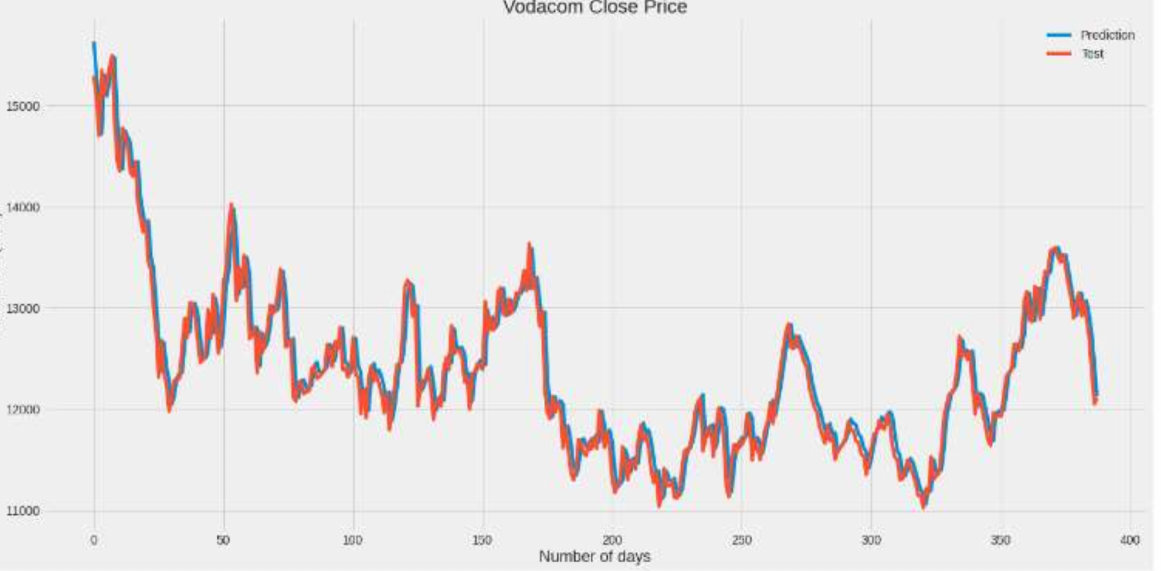
Figure 3. Bidirectional LSTM Experiment